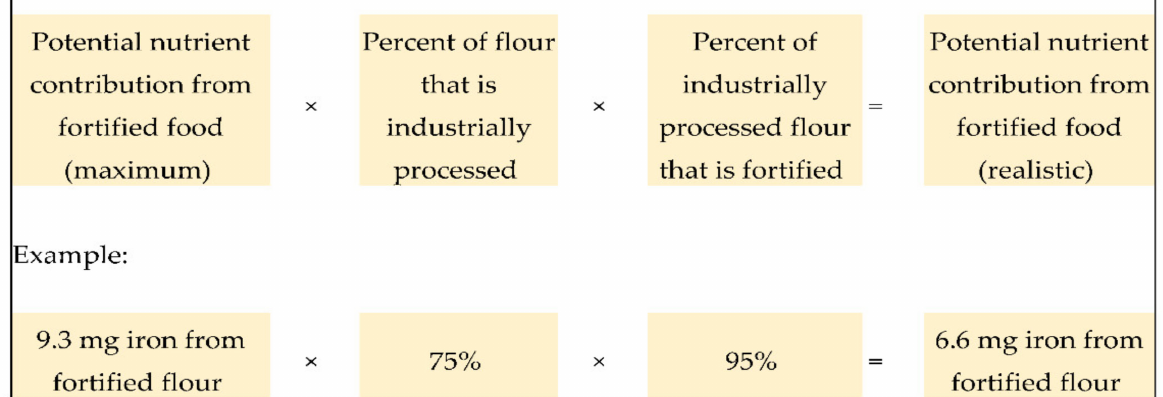
Figure 1. Calculation of potential nutrient contribution (in mg/capita/day) ( a ) under the maximum scenario where 100% of the food is assumed to be industrially processed and 100% is assumed to be fortified and ( b ) under the realistic scenario where the amount of the food that is industrially processed and fortified is known for a